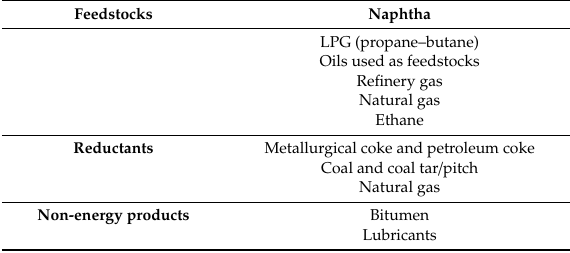
Table 1. Products used as feedstocks, reductants, and for non-energy products